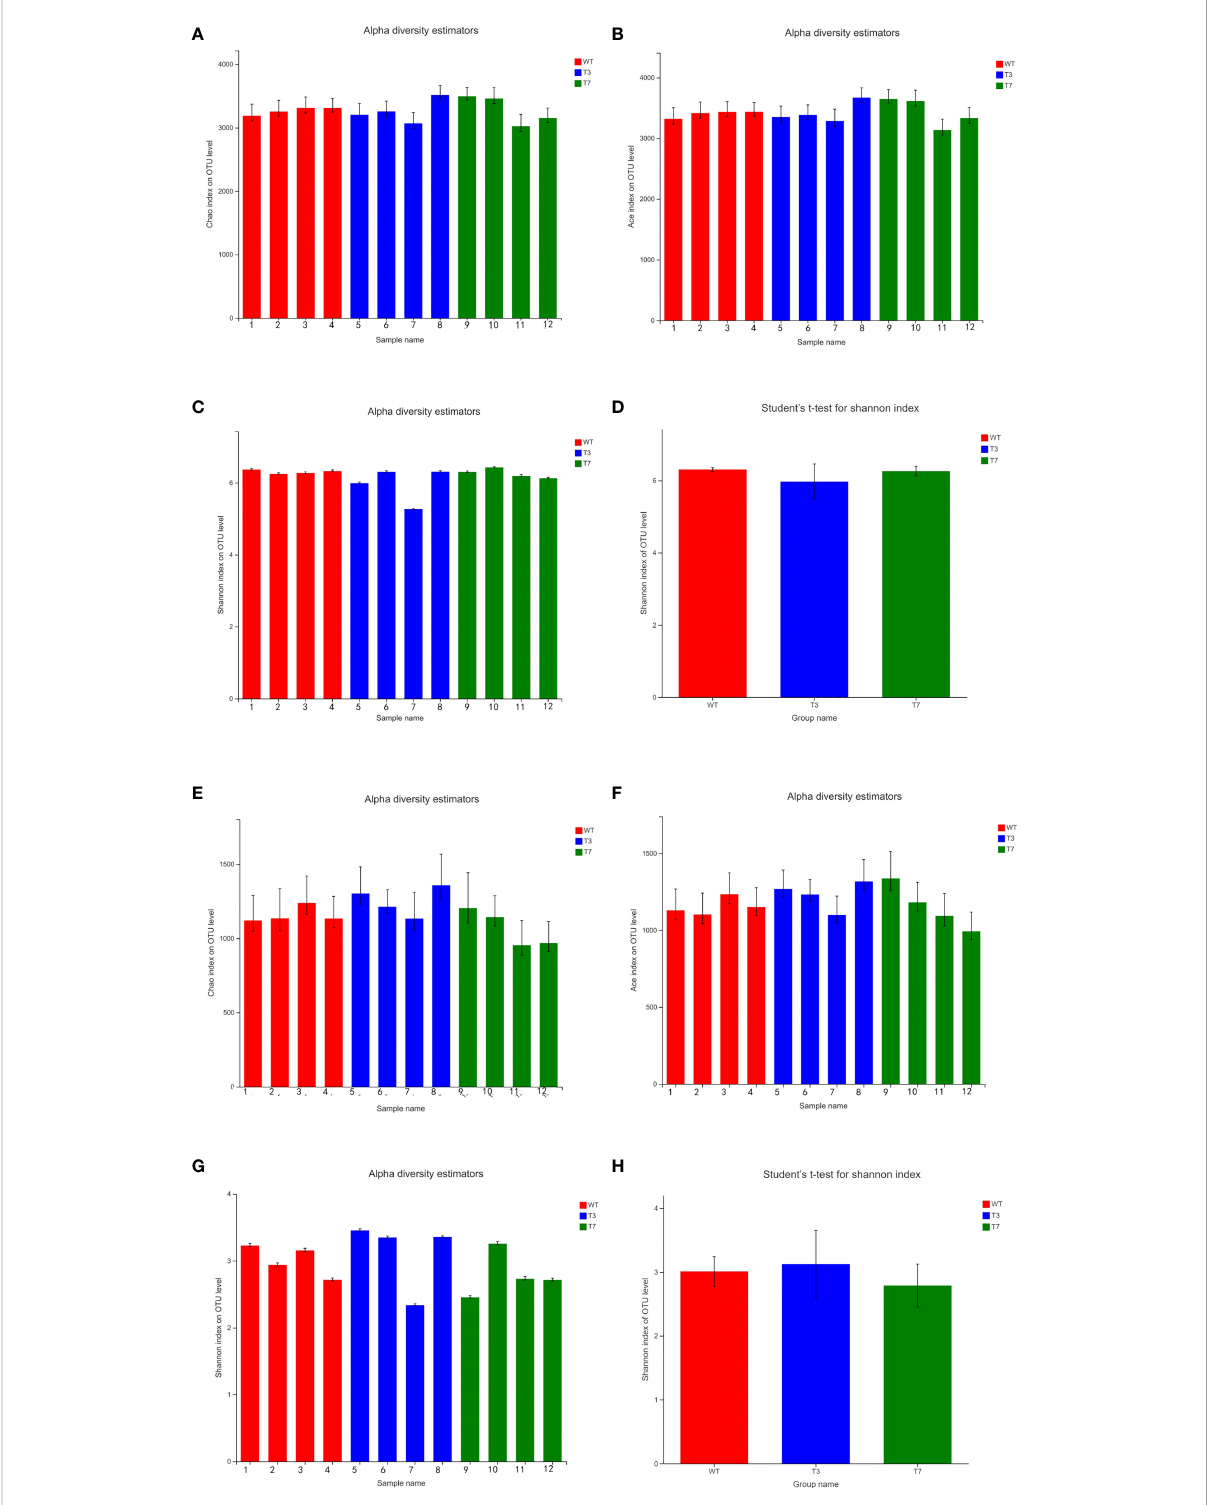
FIGURE 4 Alpha diversity index bar graph and alpha diversity signi fi cance difference test of interrooted prokaryotic and eukaryotic microbes ( A – D , bacteria; E – H , fungi). Note: Student ’ s t -test was used to calculate the difference between the two groups, and the two groups were marked with signi fi cant differences (0.01 < p ≤ 0.05 was marked with *, 0.001 < p ≤ 0.01 was marked with **, and p ≤ 0.001 was marked with